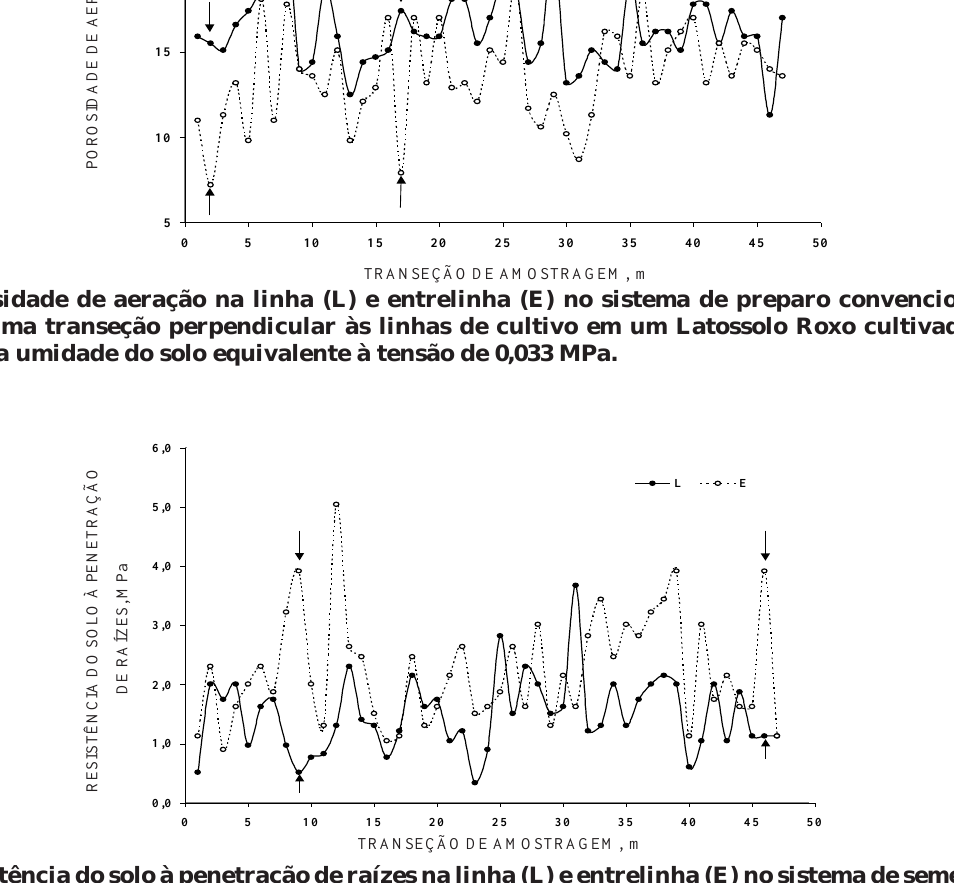
Figura 6. Resistência do solo à penetração de raízes na linha (L) e entrelinha (E) no sistema de semeadura direta ao longo de uma transeção perpendicular às linhas de cultivo em um Latossolo Roxo cultivado com milho, para umidade do solo equivalente à tensão de 0,70